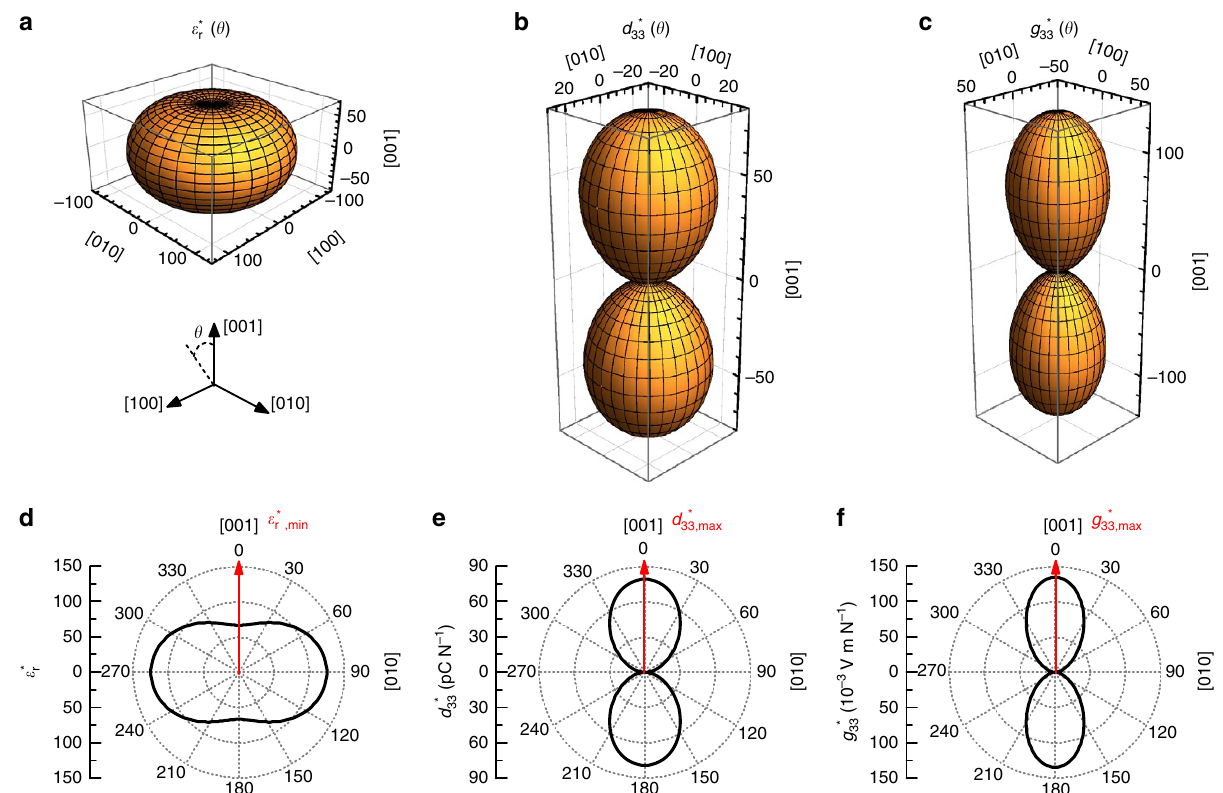
Figure 5 | Anisotropy of dielectric and piezoelectric properties. Orientation dependence of ( a ) dielectric permittivity e r *( y ), ( b ) piezoelectric strain coefficient d 33 *( y ), and ( c ) piezoelectric voltage coefficient g 33 *( y ) of tetragonal PbTiO 3 crystal. ( d ) Cross-section of the surface of ( a ); ( e ) cross-section of the surface of ( b ); ( f ) cross-section of the surface of ( c ). The coordinate system indicates crystallographic axes. Numbers on axes indicate values of e r *( y ), d 33 *( y ), g 33 *( y ),